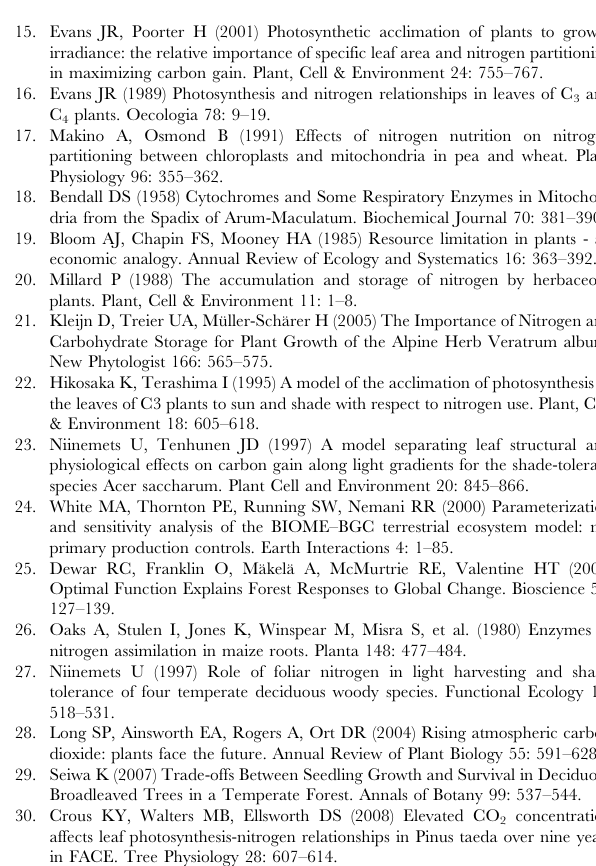
data, while dashed lines are predictions of V c,max25 by the tuned nitrogen allocation model using elevated CO 2 concentration. Panels (b)–(f) show the fitted (solid lines) and predicted (dashed lines) proportion of leaf nitrogen allocated to storage, carboxyl- ation, light capture, electron transport, and respiration, respec- tively. See Table 1 for main model inputs and Table 2 for fitted parameter values. Figure S5 Growing temperature effects on leaf nitrogen allocation for test case three. In panel (a), open and filled circles indicate observed V c,max scaled to 25 u C (i.e., V c,max25 ) for a Japanese plantain ( Plantago asiatica ) growing at temperatures of 15 u C and 30 u C, respectively, both of which are scaled to the reference temperature of 25 u C. Plants in both treatments were growing at a relatively high radiation exposure (450 m mol photon/ m 2 / s for 4 hours and 50 m mol photon/ m 2 / s for 10 hours). Solid lines are estimates of V c,max25 by the nitrogen allocation model tuned to data at the high growing temperature (30 u C), while dashed lines are predictions of V c,max25 by the tuned nitrogen allocation model using the low growing temperature (15 u C). Panels (b)–(f) show the fitted (solid lines) and predicted (dashed lines) proportion of leaf nitrogen allocated to storage, carboxylation, light capture, electron transport, and respiration, respectively. See Table 1 for main model inputs and Table 2 for fitted parameter values. Figure S6 Radiation effects on leaf nitrogen allocation for test case three. In panel (a), open and closed circles